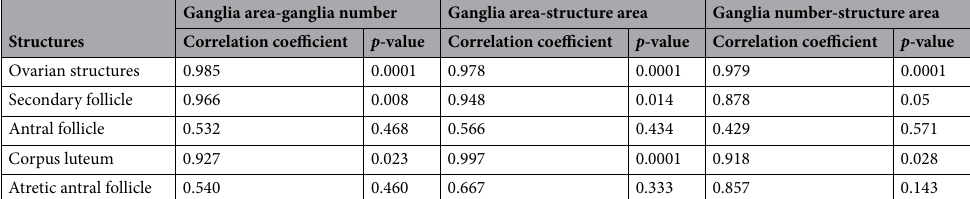
Table 2. Correlation coefficient of follicular area and ganglia development including ganglia number and area in different follicular phases and corpus luteum in three-dimensional ovary analysis.